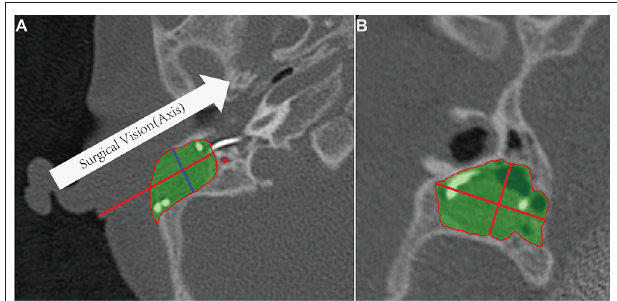
FIGURE 3 | Mastoidectomy size and related anatomic parameters. (A) Definition of surgical vision (axis) on the axial plane. The green portion is the volume of the mastoidectomy, the red line is the distance from skin to posterior tympanotomy. (B) The area, transverse length, and longitudinal width of the maximum cross-section (blue line in A ) in the direction of surgical